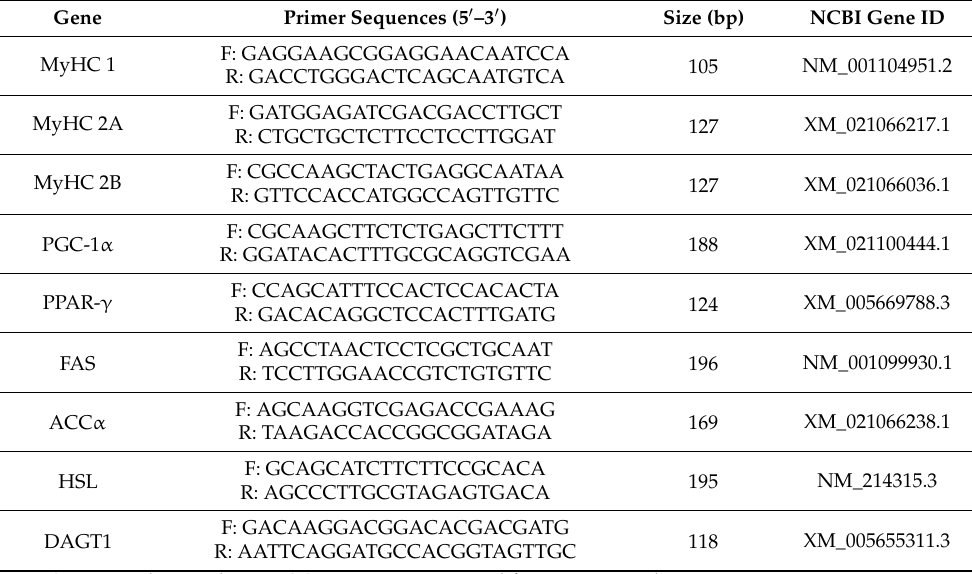
Table 2. Primer sequences used in quantitative real-time polymerase chain